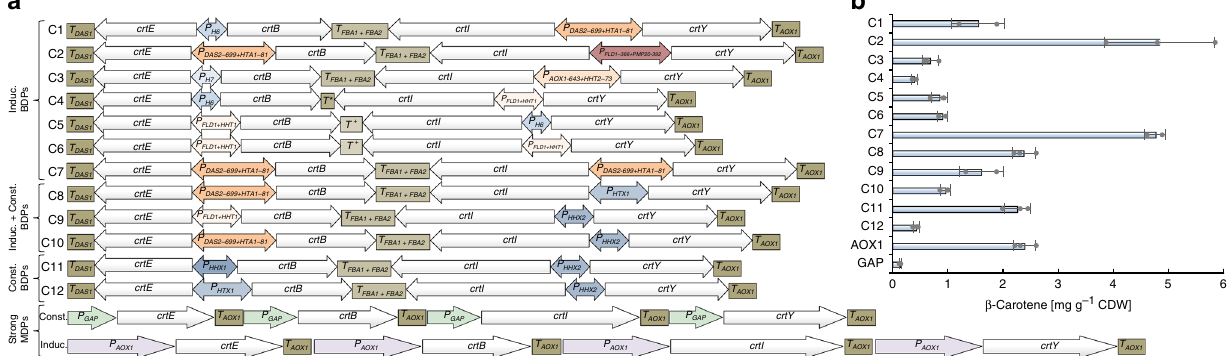
Fig. 8 The library of BDPs and BDTs facilitates the assembly and transcriptional fi ne-tuning of multi-gene pathways demonstrated with the four gene ( crtE , crtB , crtI , crtY ) model pathway of β -carotene biosynthesis. a Using BDPs and BDTs for pathway assembly reduces construct length and the number of parts required. Twelve bidirectional constructs were assembled by combining inducible or constitutive BDPs and combinations thereof (Induc. + const.) with a BDT and two MDTs. See Supplementary Fig. 5d for assembly strategy and supporting fi le Supplementary Data 2 (sheet “ Carotenoid pathway constructs ” )